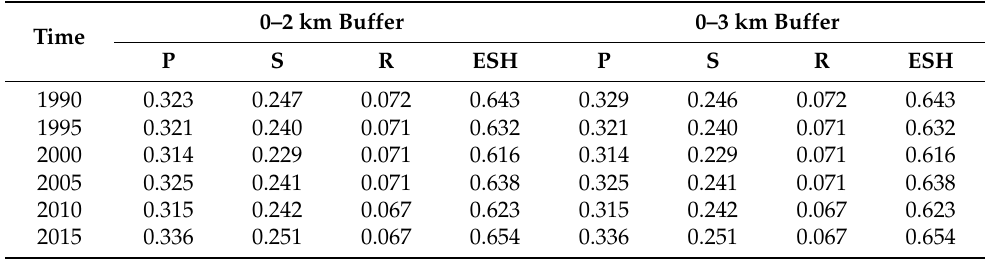
Table 4. Ecosystem health of the